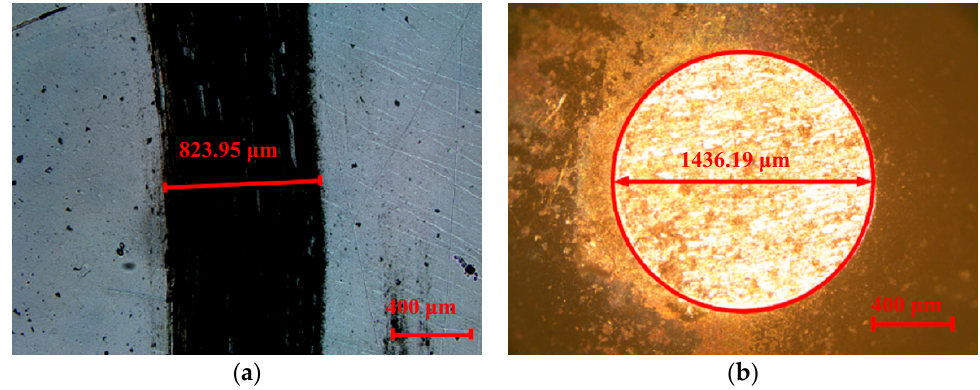
Figure 3. Images of wear scar of steel ball/a-Si:H films at 600 °C: ( a ) disc; ( b ) ball.